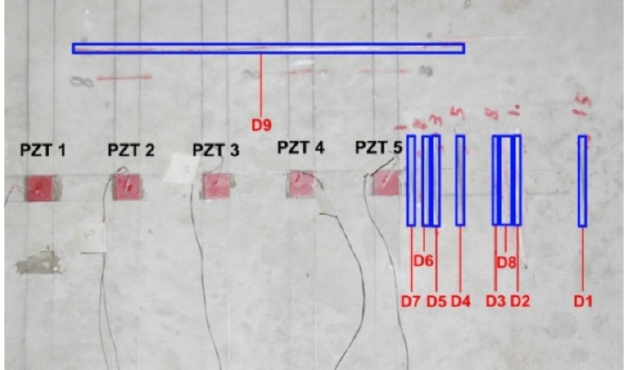
Figure 3. Location and sequence of damages on the structure.